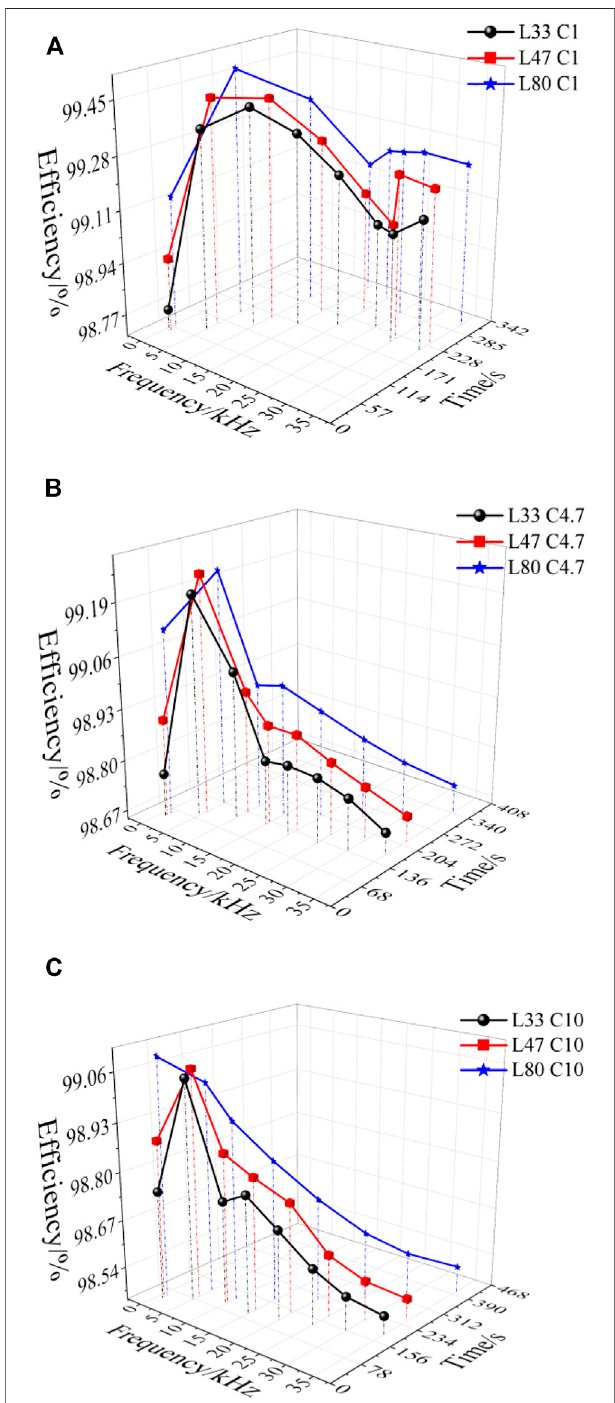
FIGURE 5 | Simulation results of the balancing ef fi ciency and time. (A) Balancingef fi ciencyandtimefora1 μ Fcapacitor. (B) Balancingef fi ciencyandtime for a 4.7 μ F capacitor. (C) Balancing ef fi ciency and time for a 10 μ F capacitor.